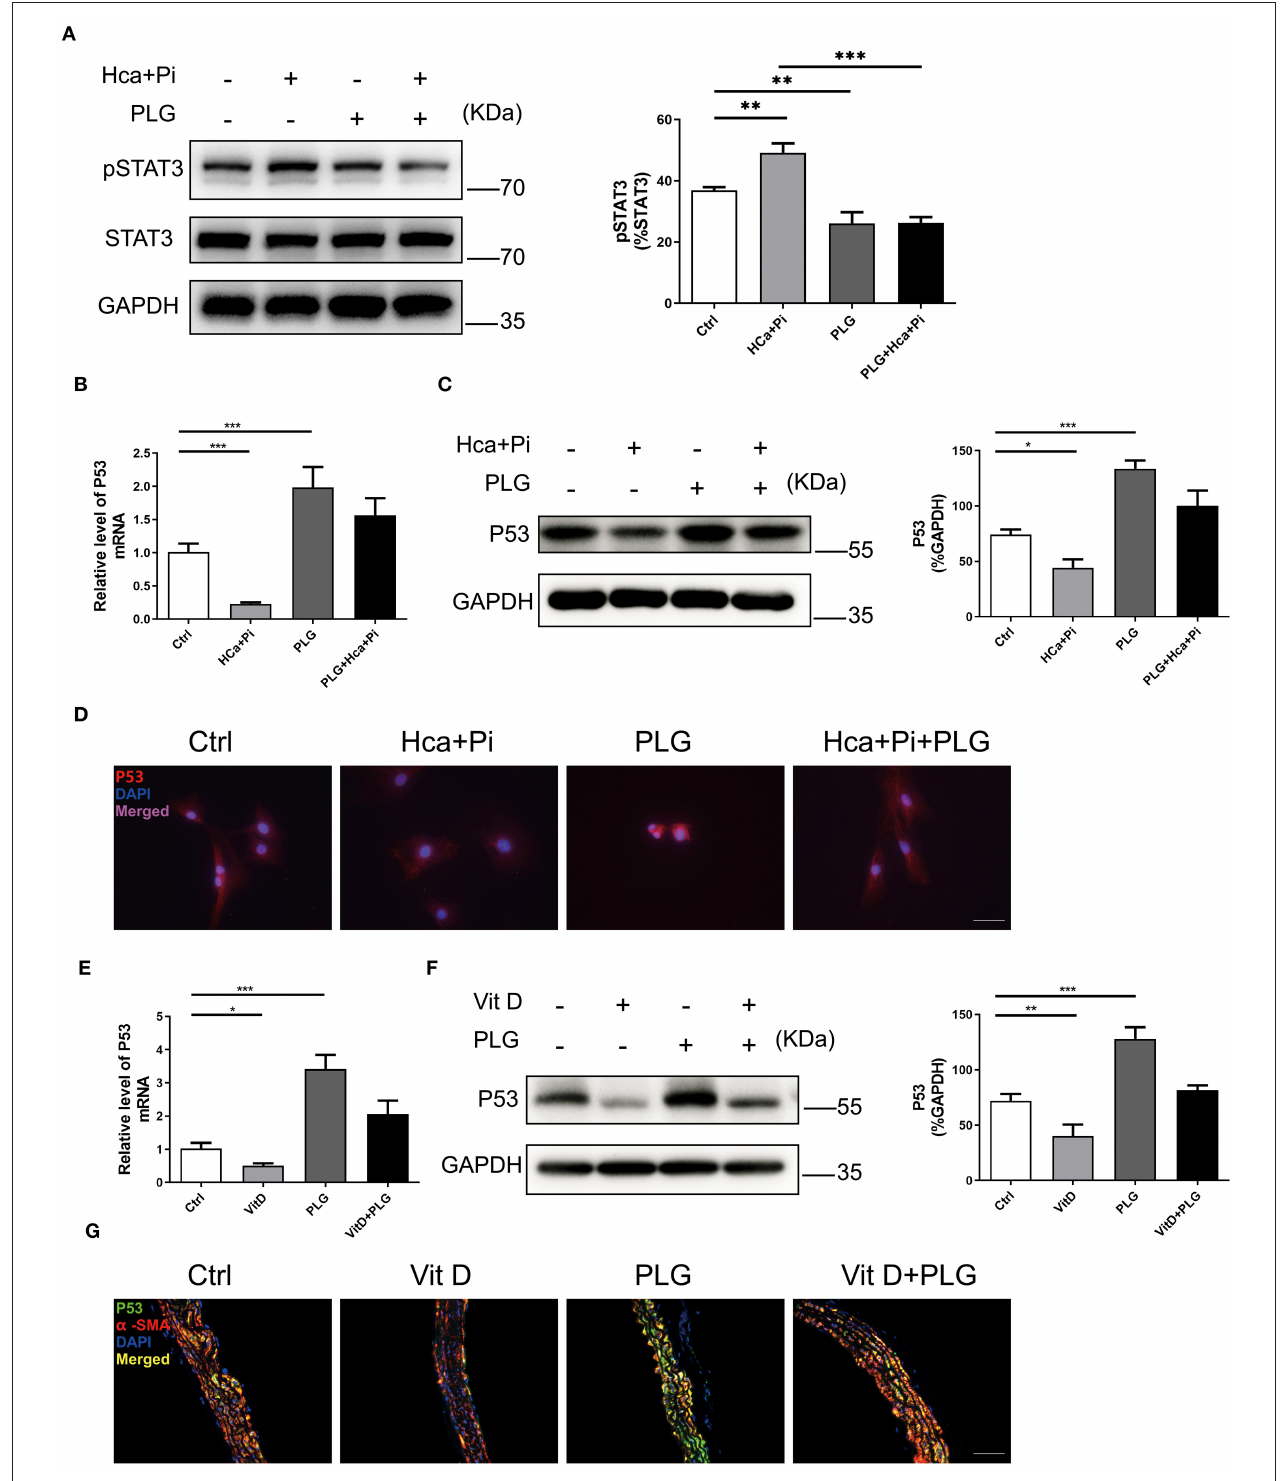
FIGURE 4 | PLG upregulates P53 signaling in vivo and in vitro . (A) The protein levels of pSTAT3 in the RVSMCs were measured by western blotting. The relative protein levels were normalized to the level of STAT3. The data are shown as the mean ± standard error of triplicate sets and are representative of three independent experiments. (B) The mRNA levels of P53 in the RVSMCs were measured by qRT-PCR ( n = 6 for each group). (C) The protein levels of P53 in the RVSMCs were